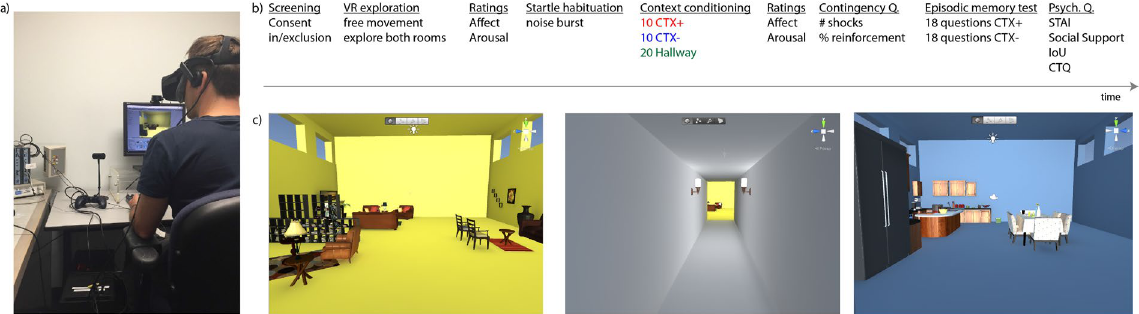
Figure 1. iVR study design. ( a ) iVR experimental set-up showing a participant (not an actual participant) wearing the Oculus Rift head mounted display while the context conditioning paradigm is presented with Unity on a standard desktop and electromyography and skin conductance responses are simultaneously recorded. ( b ) Time-line of experimental design. ( c ) 2D depiction of the two rooms and the hallway in the iVR environment (note that control buttons at the top and top right of the screen were not visible to the